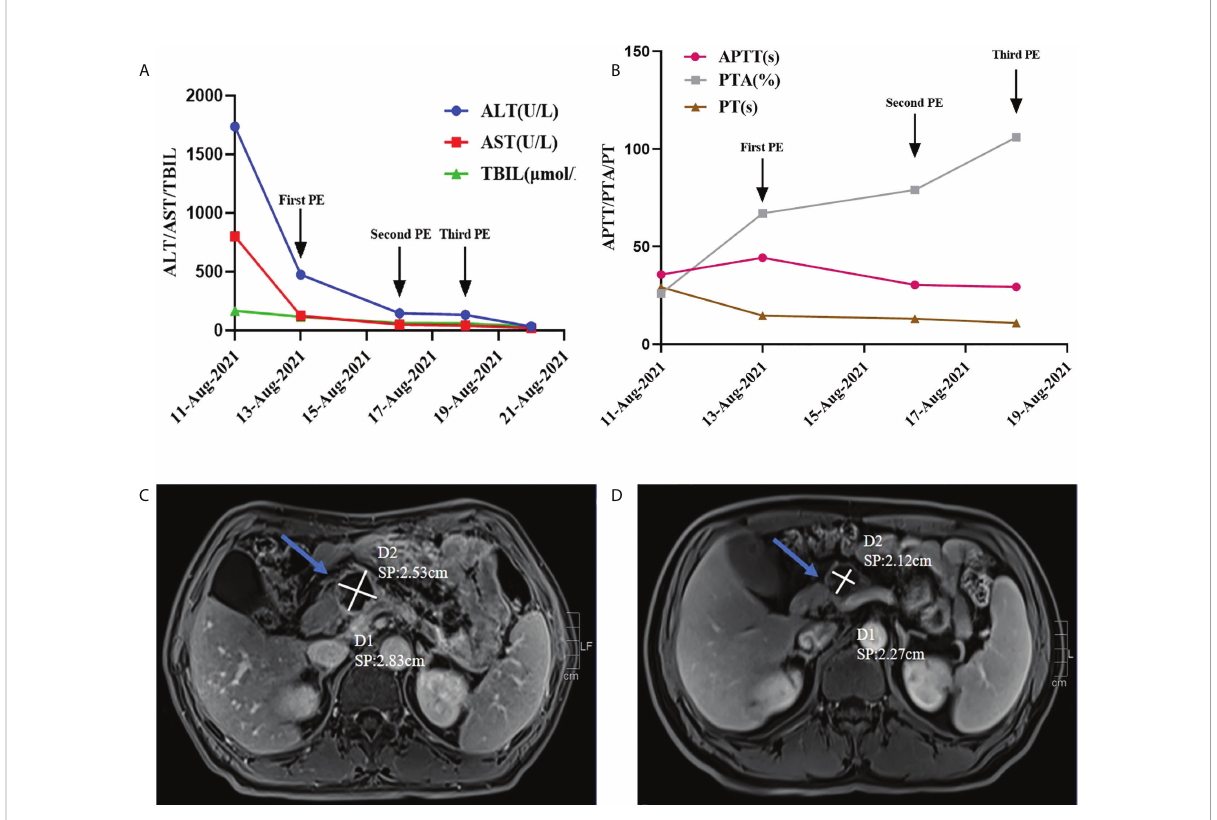
FIGURE 1 (A, B) Changes of various indicators before and after arti fi cial liver treatment; (C) On September 10, 2021, the abdominal MRI of the pancreatic neck was about 2.5*3.04cm in size (indicated by the arrow); (D) On December 9, 2021, the abdominal MRI of the pancreatic neck occupies a space of about 2.16*2.37cm (indicated by the